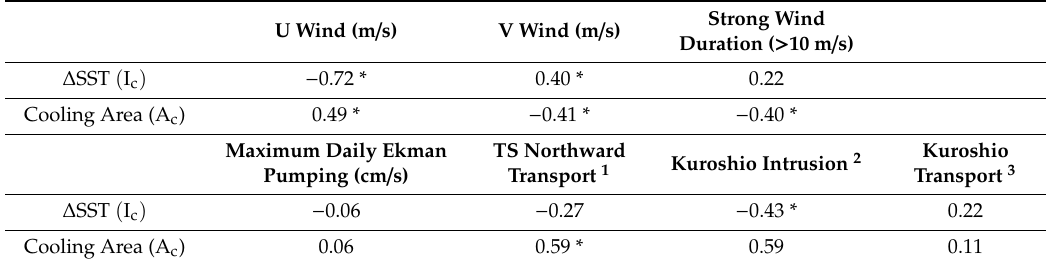
Figure 8. Di ff erence between poststorm and prestorm weekly merged sea surface height and geostrophic current vectors for the 18 typhoons shown in Figure 2. The vectors are represented by the di ff erence of geostrophic current in zonal and meridional components. Table 1. Correlation coe ffi cients between upwelling intensity (I c ), the cooling area (A c ), and the wind and current factors. Values reaching a 90% significance level are marked with